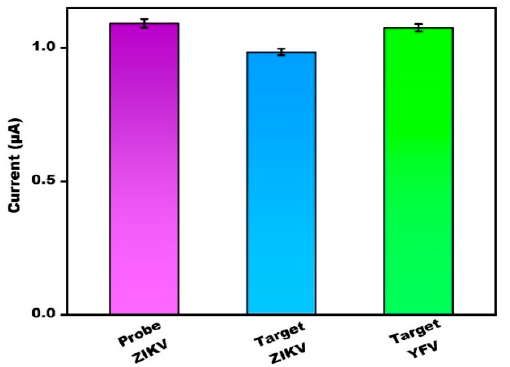
Figure 6. Bar graph depicting the CV confirmation with crossbar with the current value of probe ZIKV/target ZIKV and probe